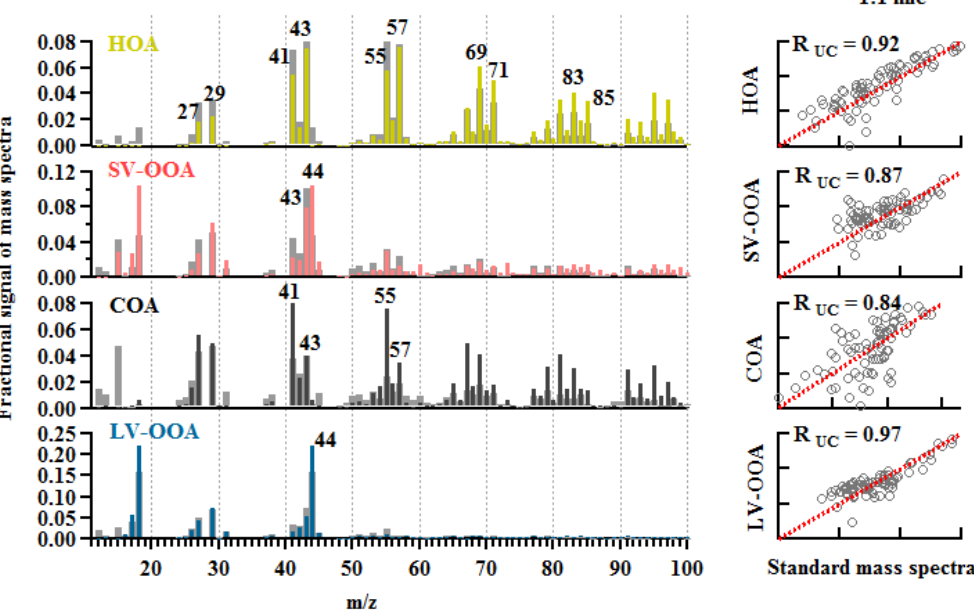
Figure 3. Mass spectra of resolved OA components (HOA, SV-OOA, LV-OOA, COA) with the corresponding standard spectra (in gray) and the correlation with standard mass spectral profiles available on the AMS MS database (Ulbrich, I. M., Lechner, M., and Jimenez, J. L., AMS Spectral Database). The x and y axes in the right-hand graphs are mass spectra of resolved factor and the standard,